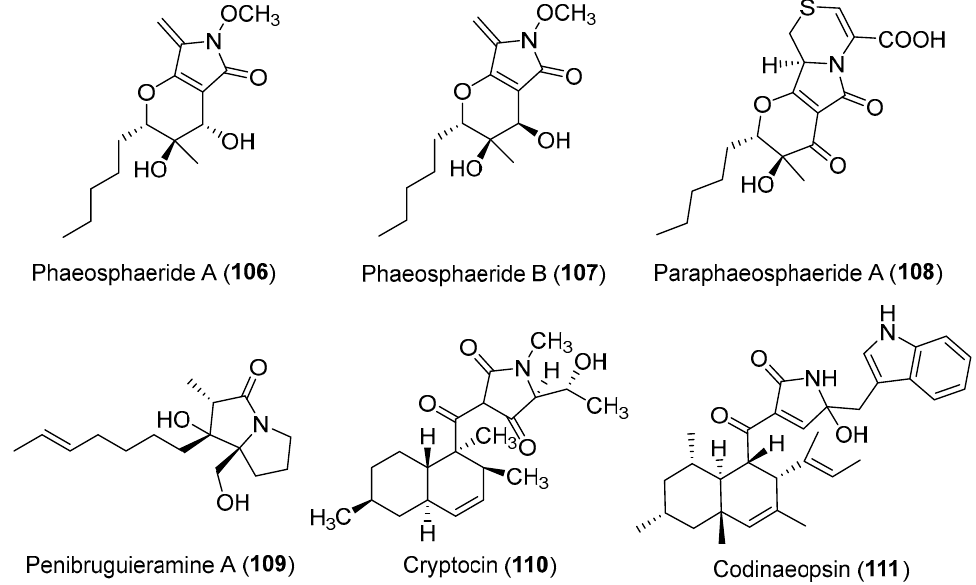
Figure 18. Structures of compounds 106 – 111 .